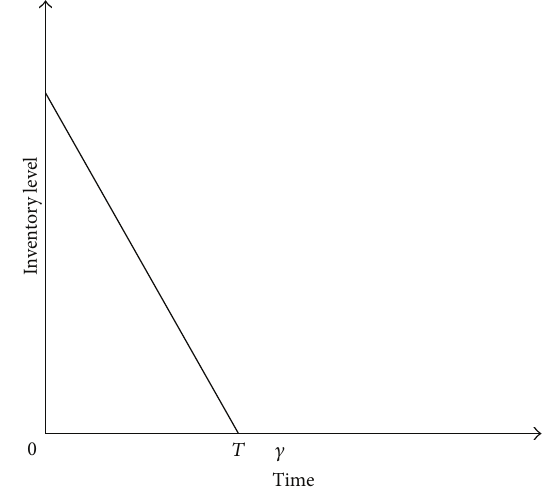
Figure 1: Inventory system for 𝑇 ≤ 𝛾